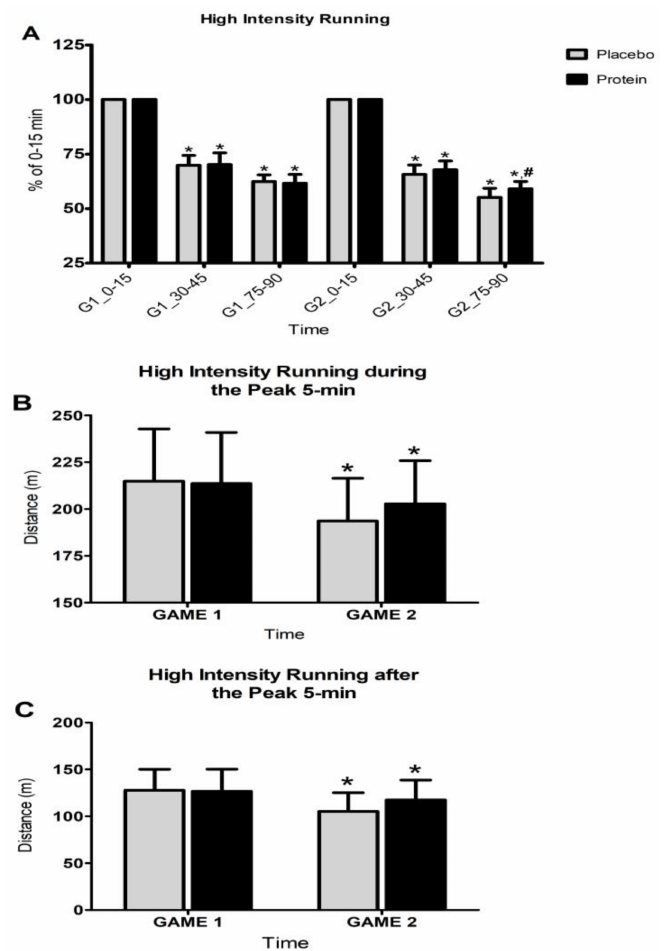
Figure 3. Changes in 15-min high-intensity running at the end of each half of each game compared to the first 15-period of the game ( A ), the high-intensity running distance during the peak 5-min ( B ), and the high-intensity running distance during the next 5-min after this peak 5-min period ( C ), during both games in each trial. G1, Game 1; G2, Game 2; * denotes a significant difference with baseline at p < 0.05; # denotes a significant difference between trials at p < 0.05.